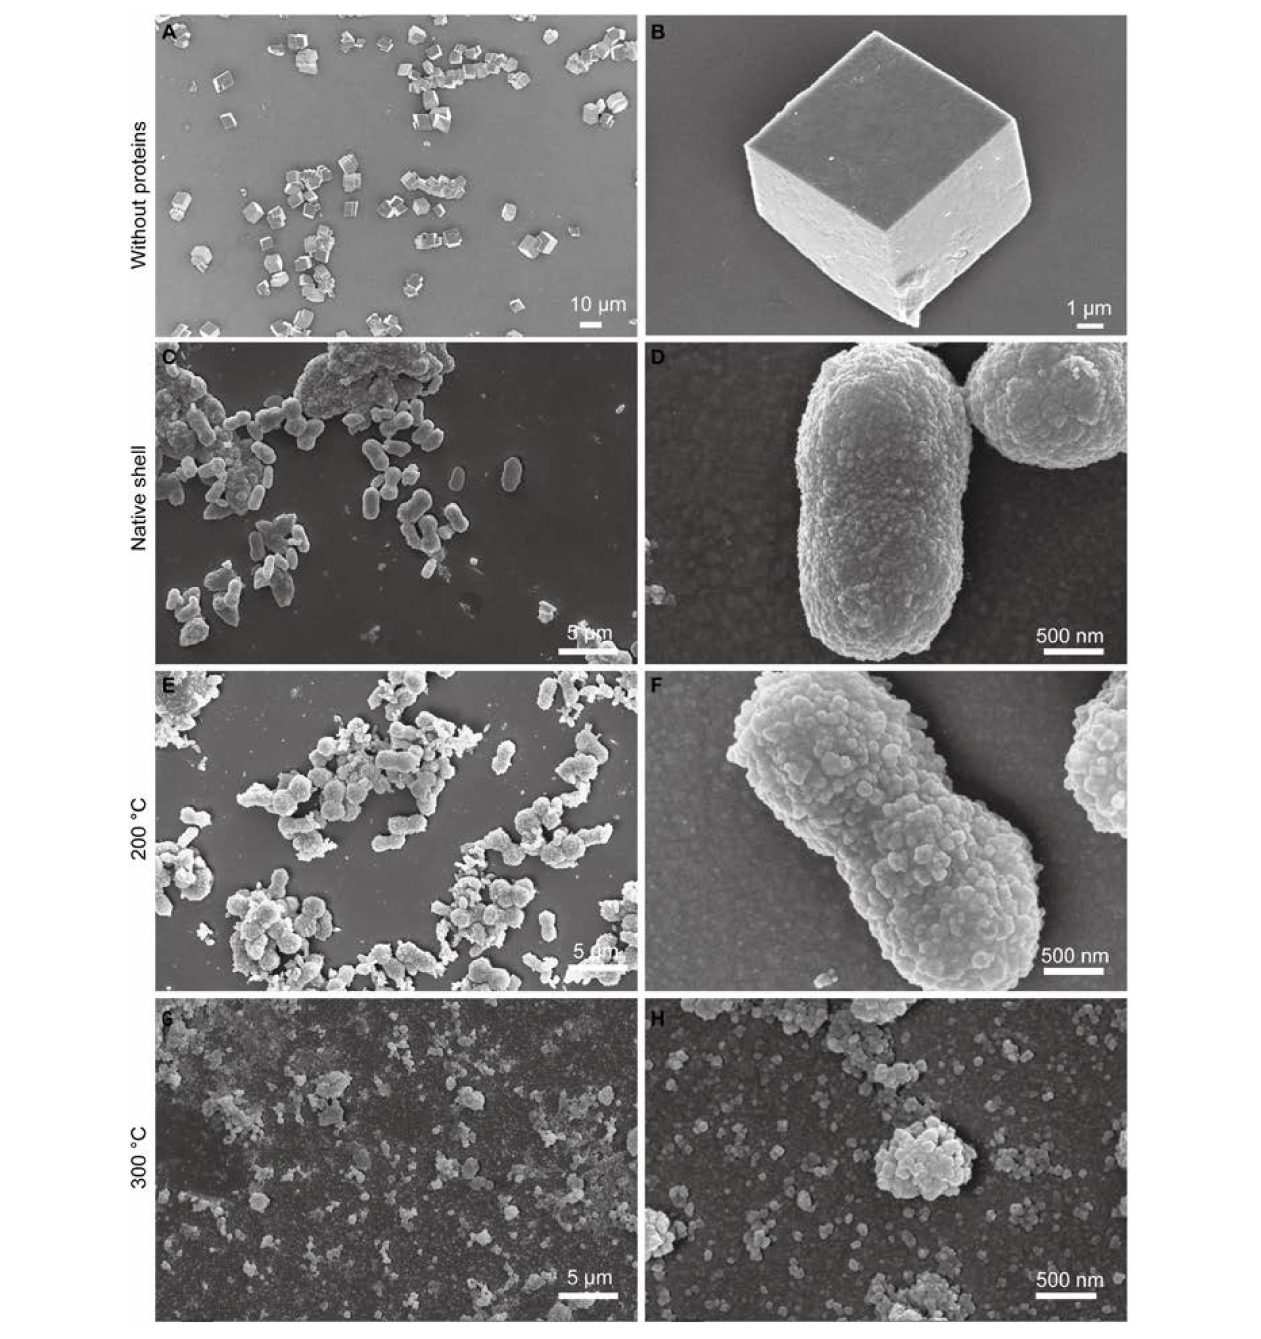
FIGURE 5 | Effects of SMPs of toasted shell on calcium carbonate crystallization. Representative SEM images of calcium carbonate crystals formed at different conditions. (A,B) Control condition without proteins; (C,D) SMPs extracted from native shells; (E,F) SMPs extracted from 200 ◦ C-toasted shells; (G,H) SMPs extracted from 300 ◦ C-toasted shells. All proteins are in the final concentration of 150 µ